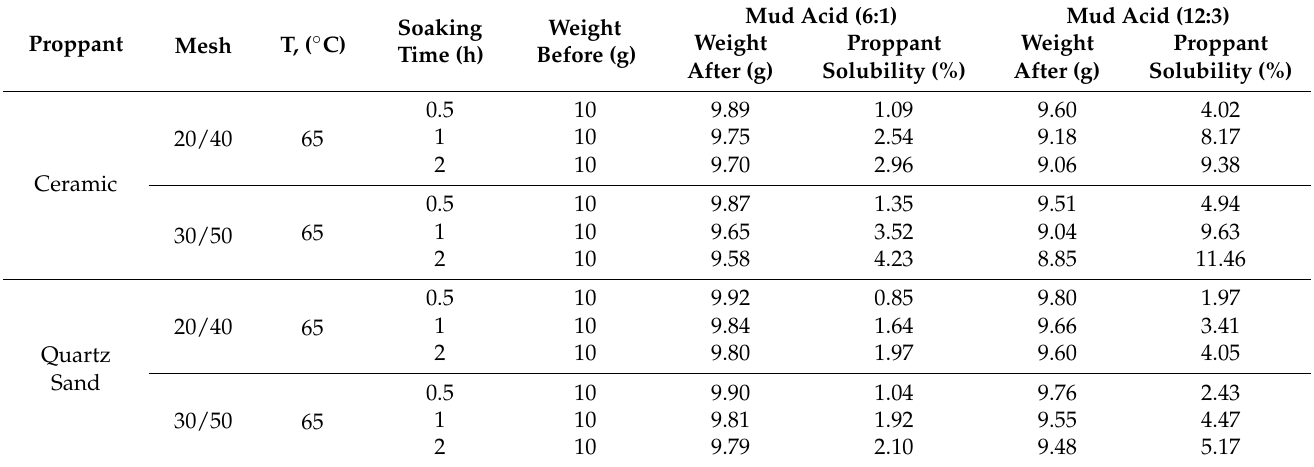
Table 2. Acid solubility of proppants under different acid solutions and soaking times.